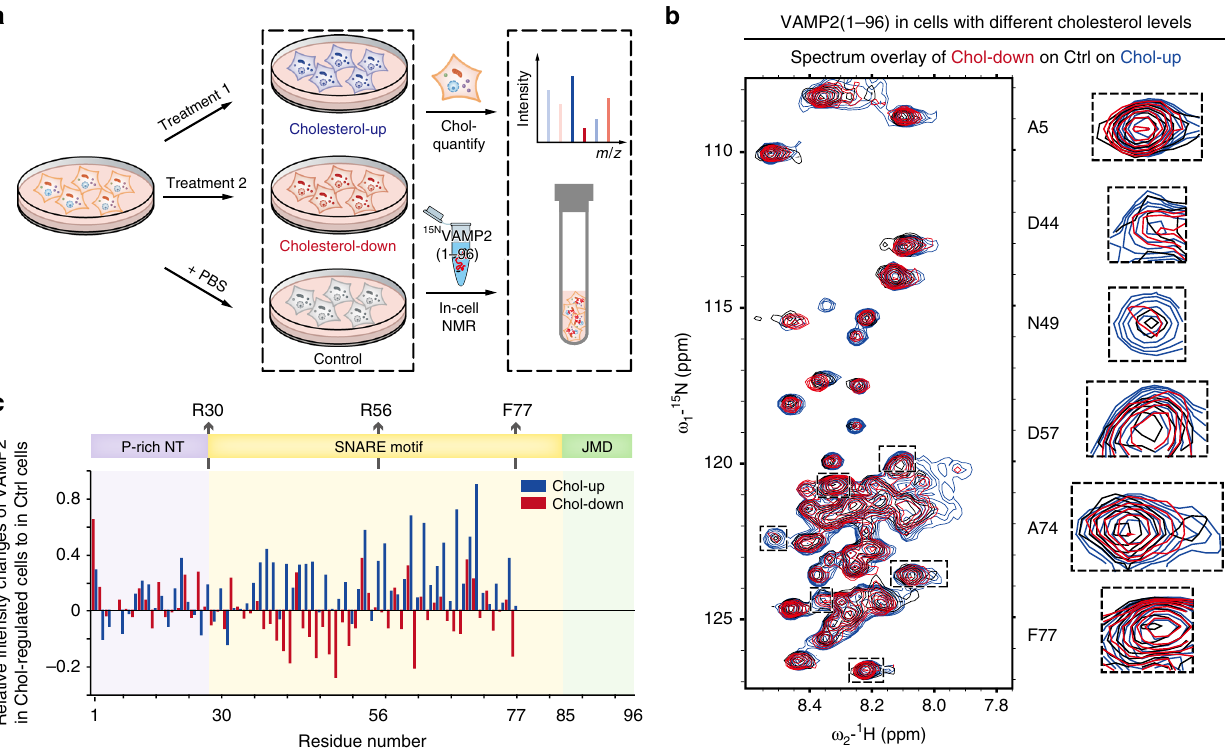
Fig. 2 Residue-speci fi c structural change of VAMP2(1 – 96) in cholesterol up- and down-regulated cells. a Scheme of experimental design for studying the conformations of VAMP2 in cholesterol-level-regulated cells. Treatments 1 and 2 for increasing and decreasing cellular cholesterol levels were noted in the Methods section. b Overlay of 2D 1 H- 15 N NMR spectra of VAMP2(1 – 96) in cholesterol up-regulated (Chol-up, blue), down-regulated (Chol-down, red) and control (Ctrl, black) HEK-293T cells at the same contour levels. Representative crosspeaks were enlarged on the right. c Relative NMR signal intensity changes of VAMP2(1 – 96) in Chol-up (blue) and Chol-down (red) cells to those in control cells. Details of data processing are described in the Methods section. Source data are provided as a Source Data fi